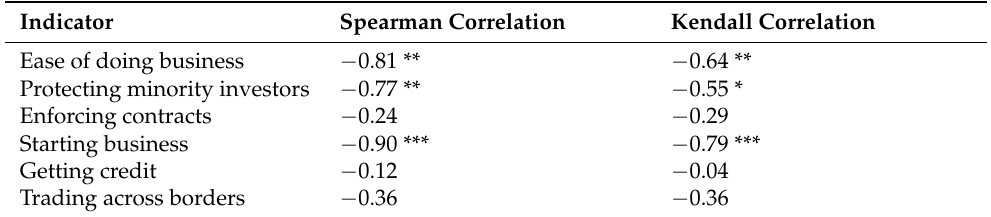
Table 2. Nonparametric correlation between NIS efficiency score and indicators of business environ- ment and legislation.